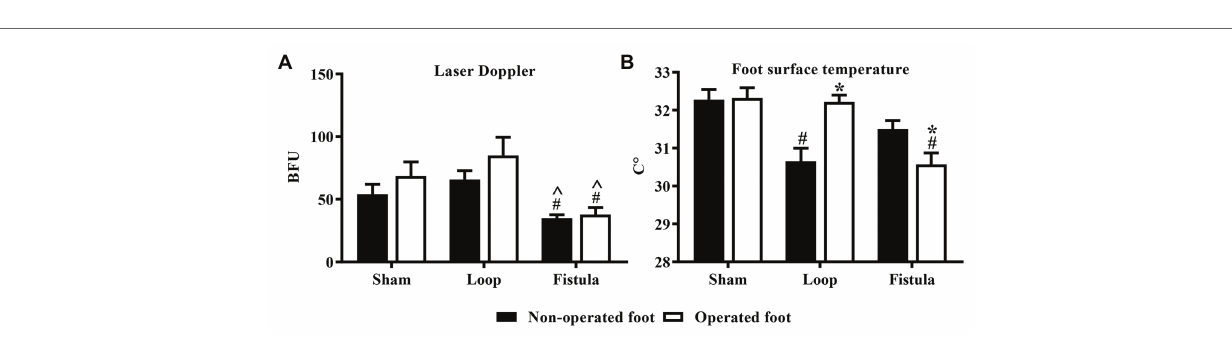
FIGURE 7 | Results of microcirculatory measurements on various regions in the sham-operated (A) , loop (B) , and fistula (C) groups. n = 10, mean ± SEM, * p < 0.05 vs. non-operated foot after operation, # p < 0.05 vs. operated foot after operation.